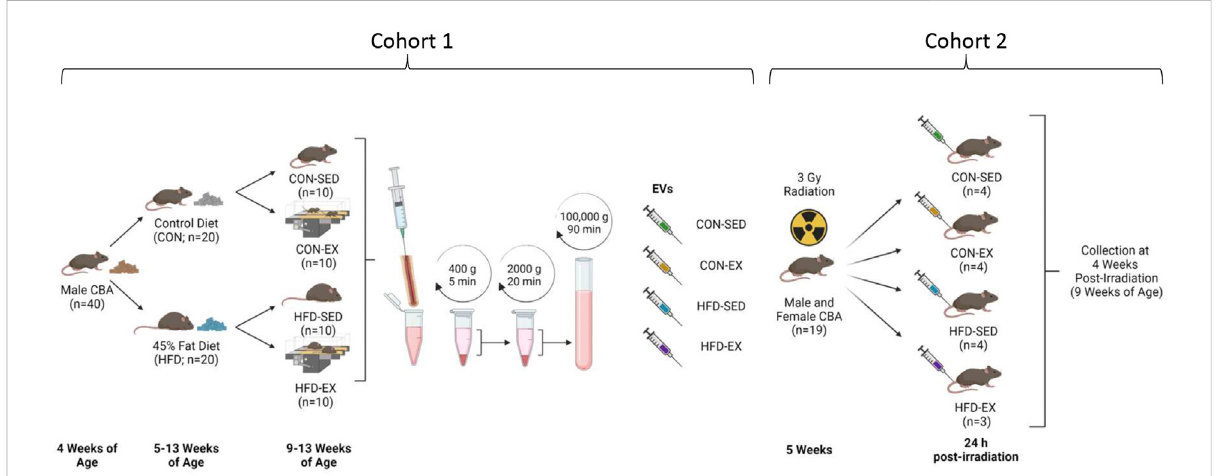
FIGURE 1 Study outline for EV isolation and injection. Male CBA mice ( n = 40) were placed on high-fat (HFD) or control (CON) diets for 8 weeks with the latter 4 weeks including exercise (EX) or sedentary (SED) conditions. Bone marrow was extracted, and extracellular vesicles (EVs) isolated by differential centrifugation. Collected EVs were combined by group and injected into new male and female CBA mice by tail vein 24 h following ionising radiation injury. Bone marrow samples were collected at 4 weeks post-irradiation. Created with